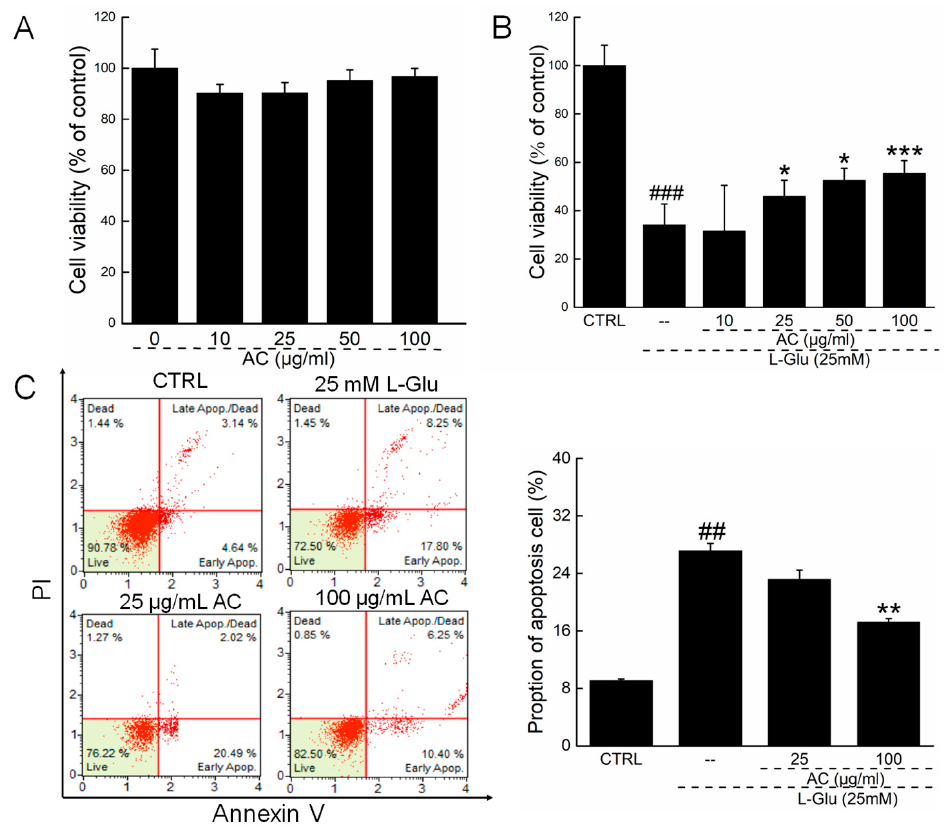
Figure 1. AC ameliorated L -Glu-induced cytotoxicity and apoptosis in HT22 cells. ( A ) AC has no significant influence on HT22 cell viability; ( B ) AC enhanced cell viability in L -Glu-damaged HT22 cells after 24 h co-incubation; ( C ) AC reduced proportion of the apoptotic cells in L -Glu-exposed HT22 cells detected by Annexin V-FITC/PI staining. Data are expressed as mean ± S.D. ( n = 6). ## p < 0.01 and ### p < 0.001 vs. CTRL. * p < 0.05, ** p < 0.01 and *** p < 0.001 vs. L -Glu-treated cells.